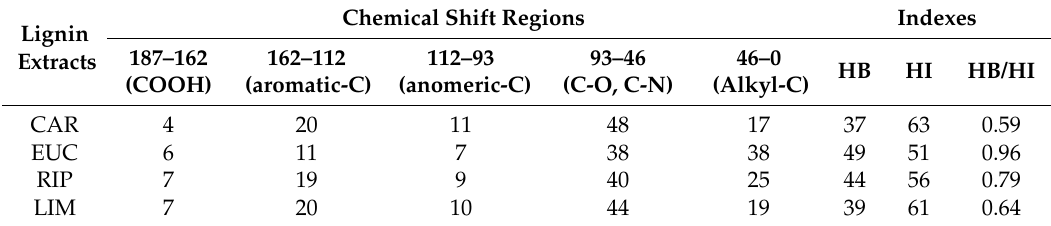
Figure 2. 13 C-CPMAS-NMR spectra of water-soluble lignins isolated from cardoon (CAR), eucalyptus (EUC), black poplar grown in Ripiti (RIP) and black poplar grown in Limatola (LIM) by an alkaline oxidative extractant. Table 1. Carbon distribution (%) in different chemical shift regions (ppm) in 13 C-CPMAS-NMR spectra of lignins from cardoon (CAR), eucalyptus (EUC), black poplar grown in Ripiti (RIP) and black poplar grown in Limatola